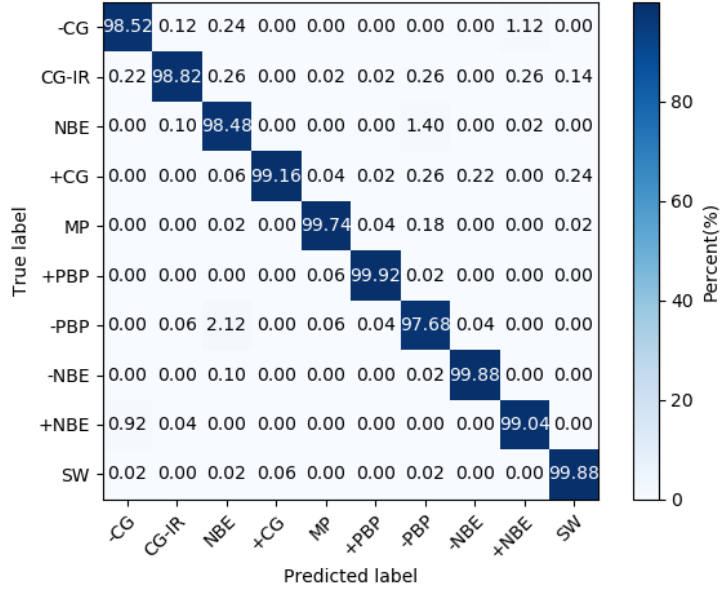
Figure 7. Confusion matrix for classification results.